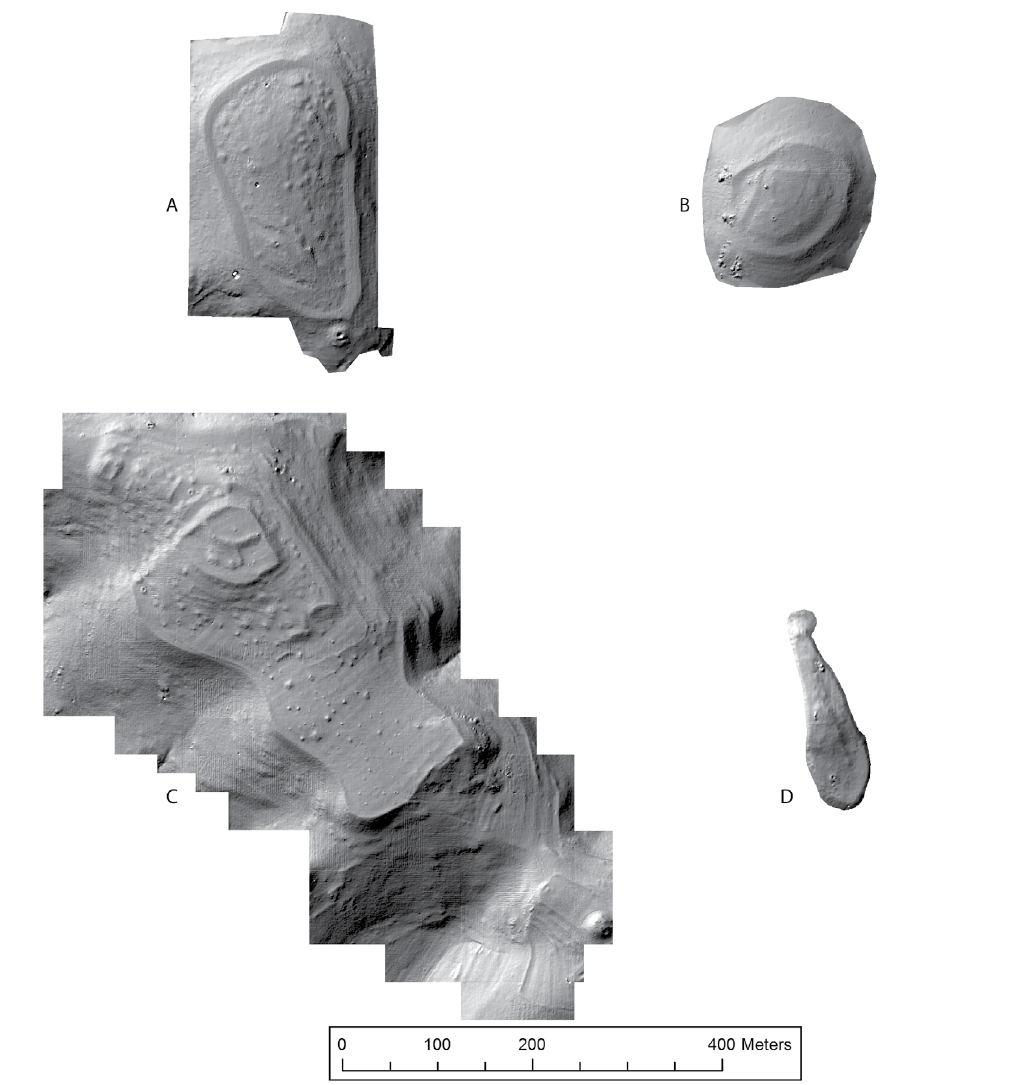
Figure 4: Hillshade models resulting from RTK GNSS survey of sites listed in Table 1: a) Asar Tepe 2; b) Gedevre Tepesi; c) Kaymakçı; and d) Kızbacı